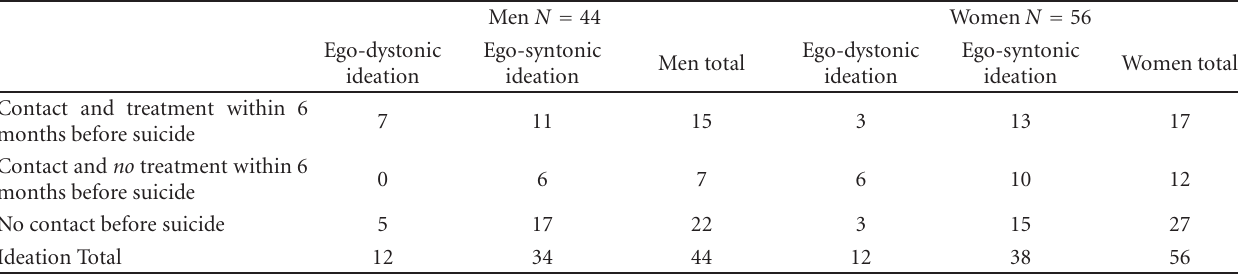
Table 1: Ego-dystonic and ego-syntonic suicidal ideation related to treatment by contact and gender.